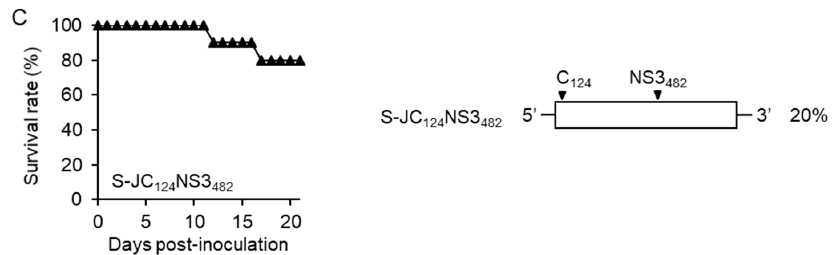
Figure 4. Mortalities of mice infected with recombinant viruses inserting point mutations. ( A ) Survival curves and mortality rates of mice infected with 10 4 pfu of S-JC 124 3a ( n = 10) and S-JM 140 3a ( n = 10) viruses based on S982-IC containing genome region 3a of JaTH-IC, in which amino acids C 124 and M 140 were replaced with those of JaTH-IC, respectively. ( B ) Survival curves and mortality rates of mice infected with 10 4 pfu of S-J1aNS3 323 ( n = 5), S-J1aNS3 337 ( n = 8), S-J1aNS3 482 ( n = 10), S-J1aNS3 562 ( n = 5), S-J1aNS4A 3 ( n = 10), and S-J1aNS4B 18 ( n = 5) viruses based on S982-IC containing genome region 1a of JaTH-IC, in which amino acids NS3 323 , NS3 337 , NS3 482 , NS3 562 , NS4A 3 , and NS4B 18 were replaced with those of JaTH-IC, respectively. ( C ) Survival curves and mortality rates of mice infected with 10 4 pfu of S-J C 124 NS3 482 ( n = 10) virus based on S982-IC, whose amino acid positions of C 124 and NS3 482 were of JaTH160-IC. Closed triangles indicate recombinant viruses. The black inverted triangles indicate the positions and numbers of amino acids derived from JaTH-IC.